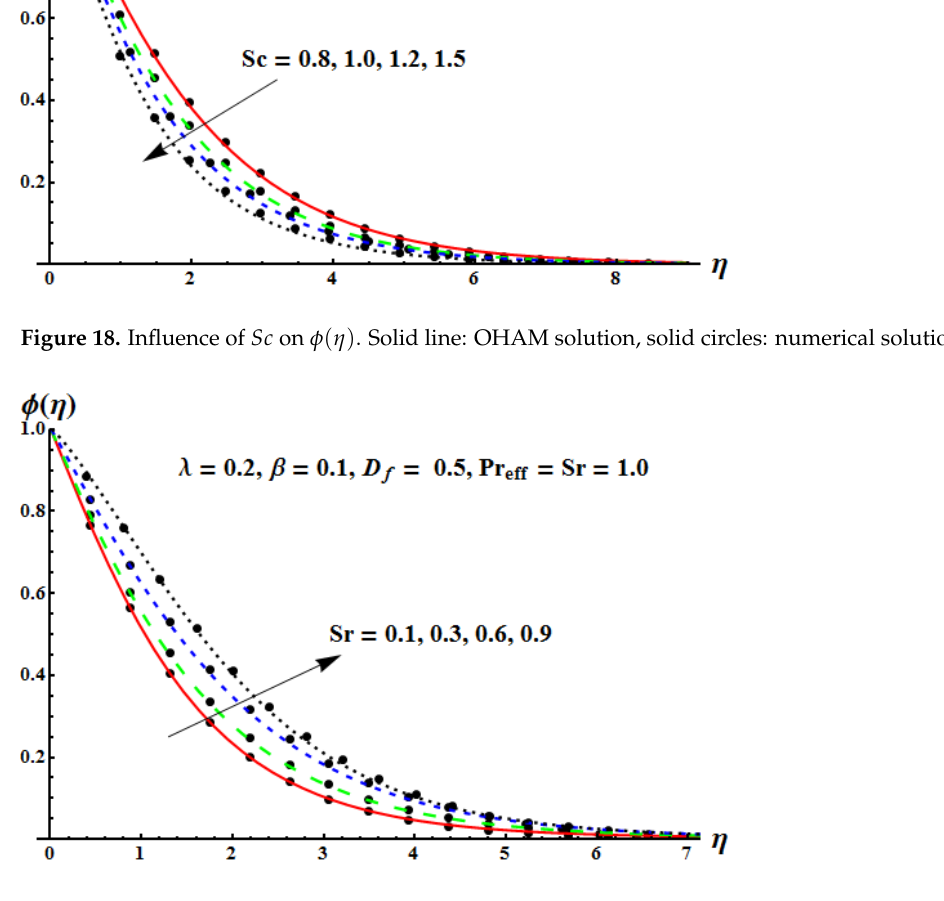
Figure 19. Influence of Sr on φ ( η ) . Solid line: OHAM solution, solid circles: numerical